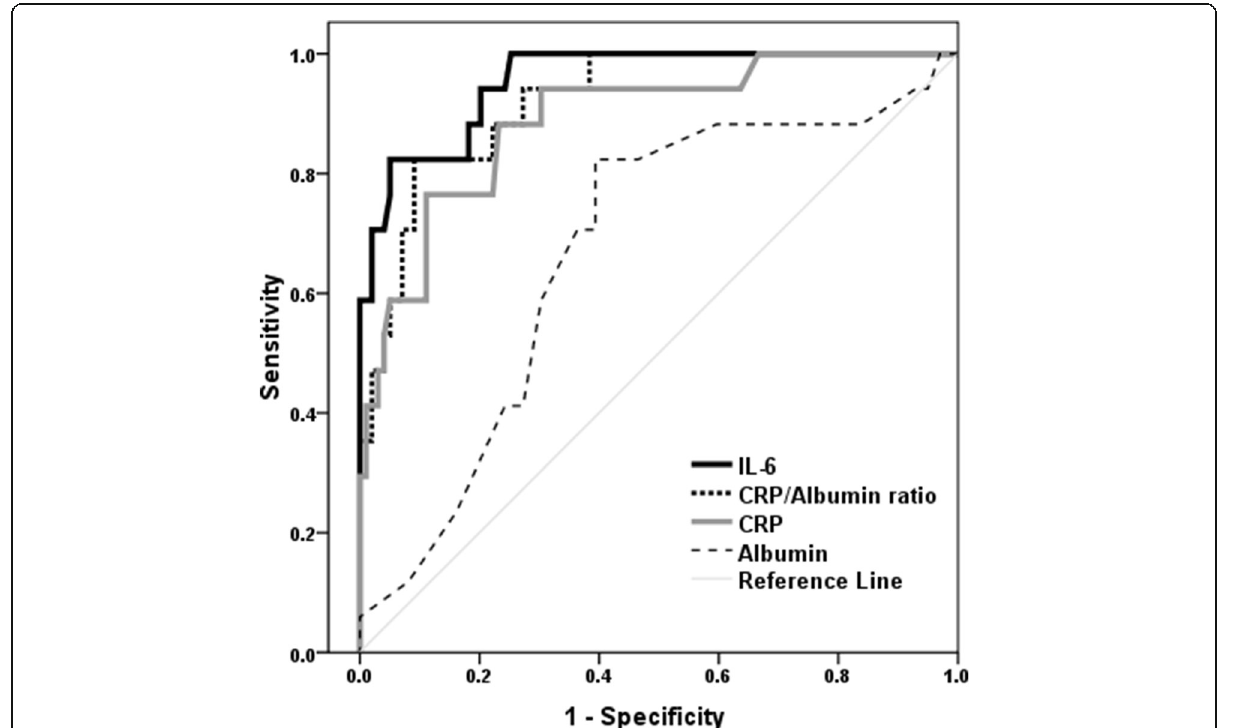
Fig. 2 ROC curve of laboratory markers as predictors of COVID-19 severity